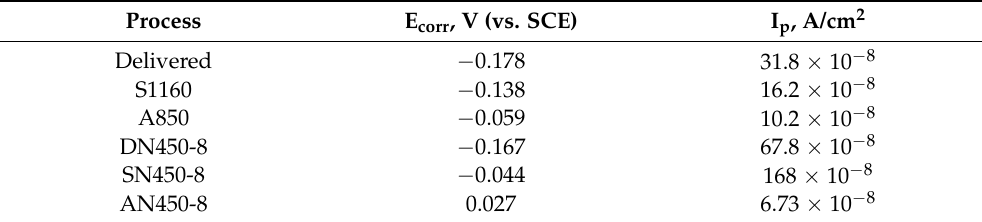
Table 5. Corrosion potential and corrosion current density of AISI 430 stainless steel before and after plasma